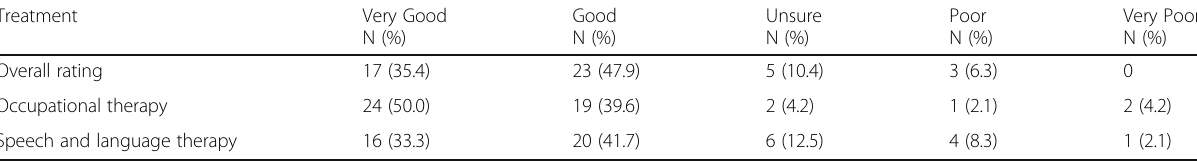
Table 2 Responses of parents in rating their satisfaction towards treatment received Treatment Very Good N